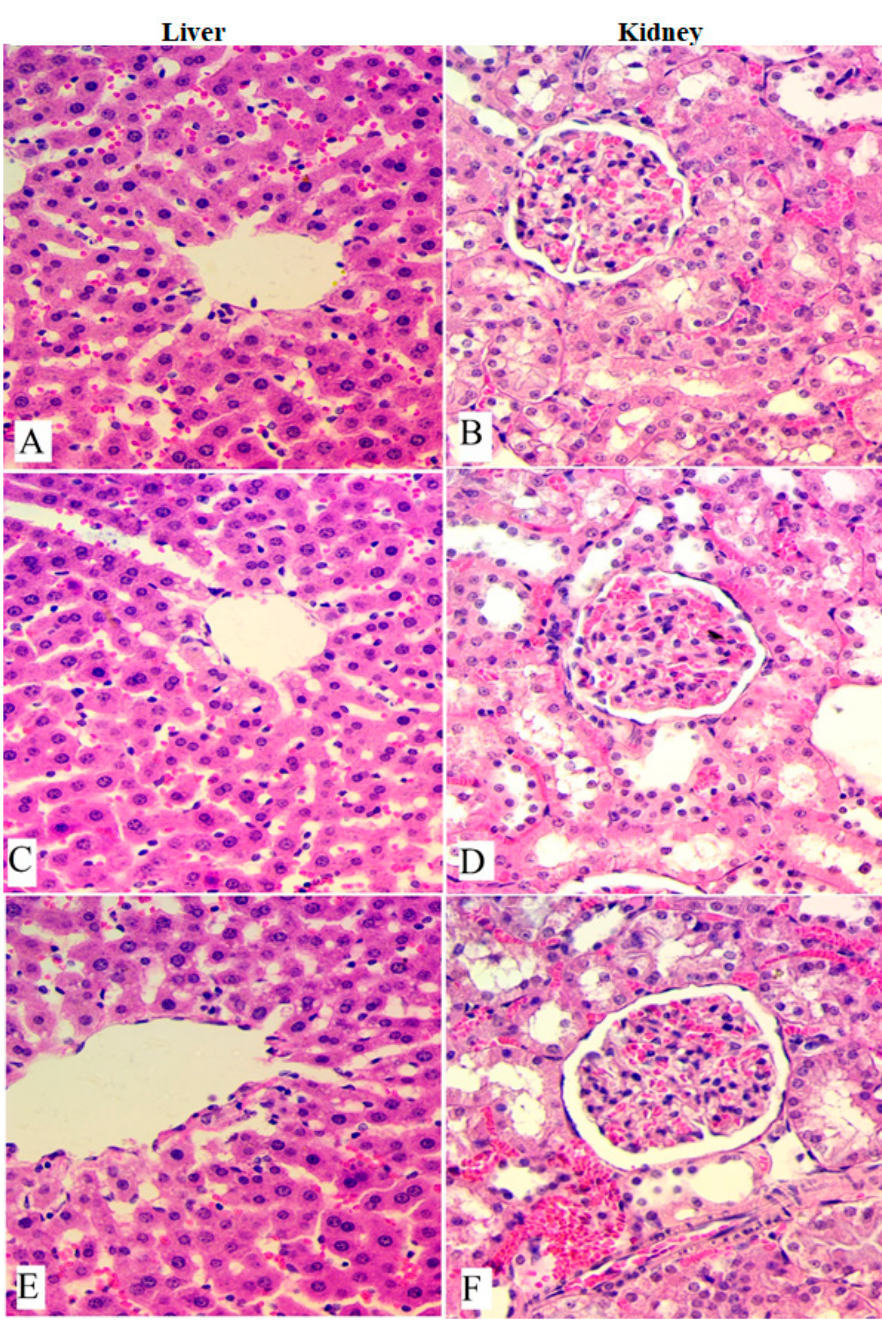
Figure 1. Histological views of liver and kidney obtained from rats in acute toxicity test. ( A , B ), Nor- mal control; ( C , D ), rats administered 1000 mg/kg of OME; ( E , F ), rats treated with 2000 mg/kg of OME. Non-significant changes were observed between the experimental and normal rats according to microscopic views. H & E stain; magnification, 40×.